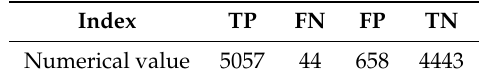
Table 19. Detection evaluation indices.